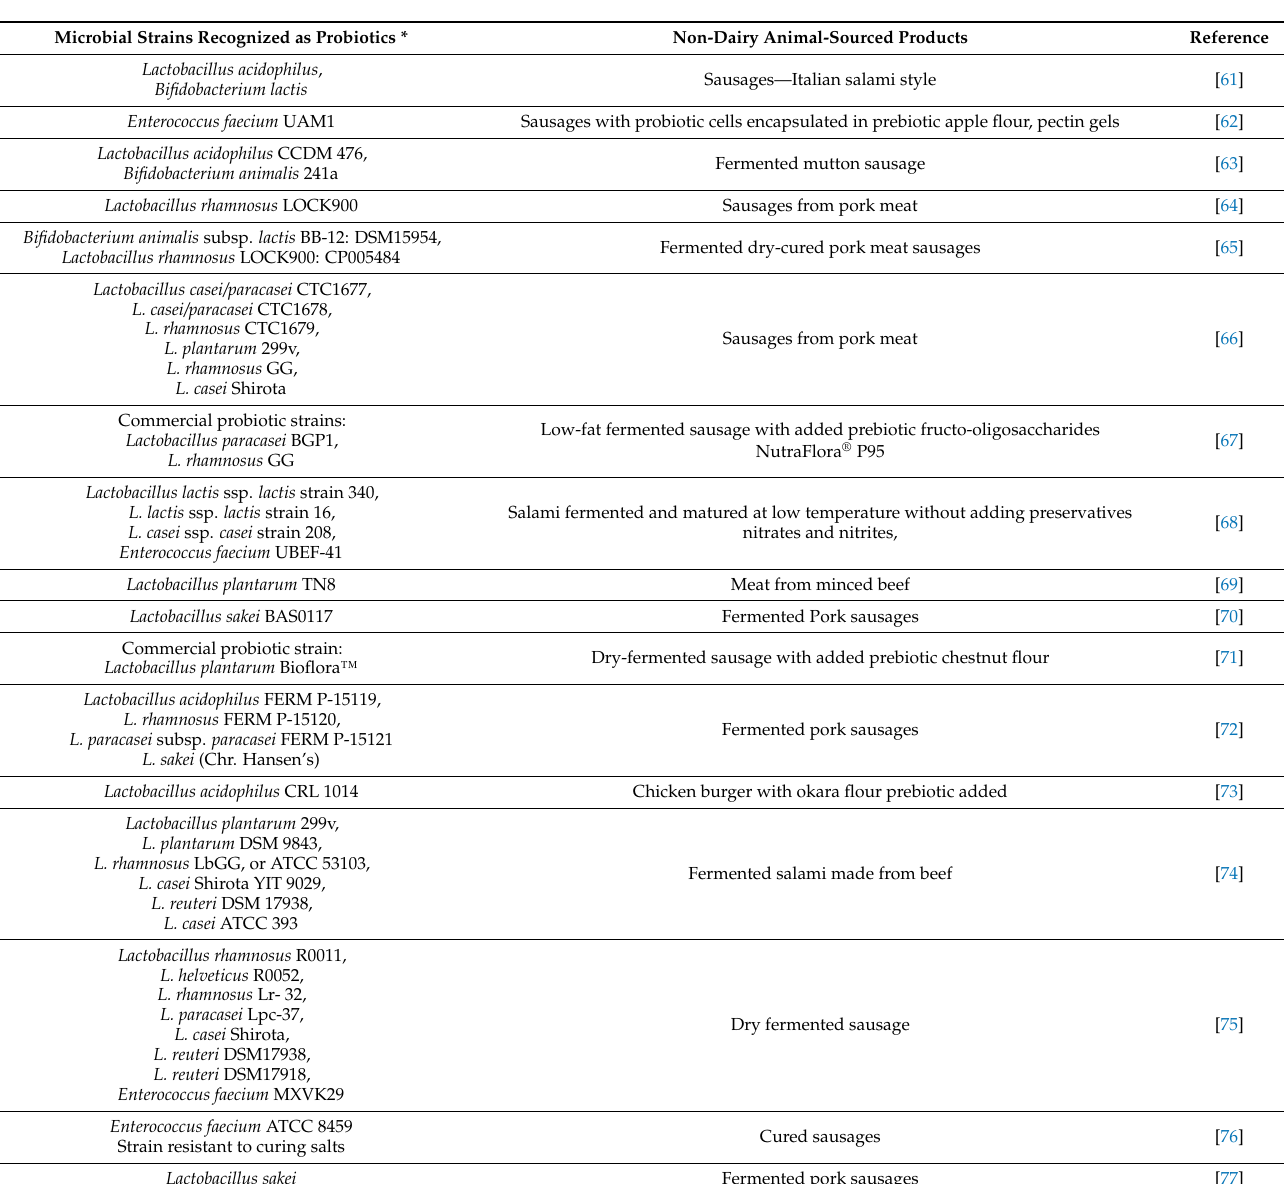
Table 3. Probiotic strains * used for the preparation of non-dairy food for lactose-intolerant